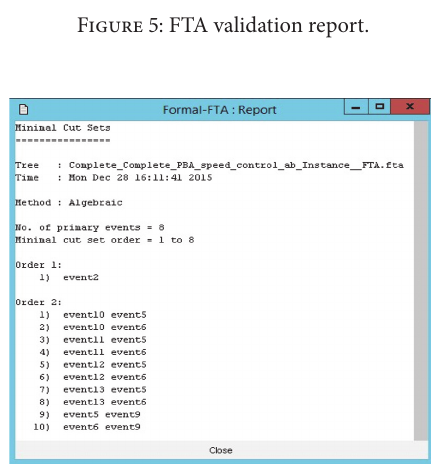
Figure 6: Minimal cut set analysis report from